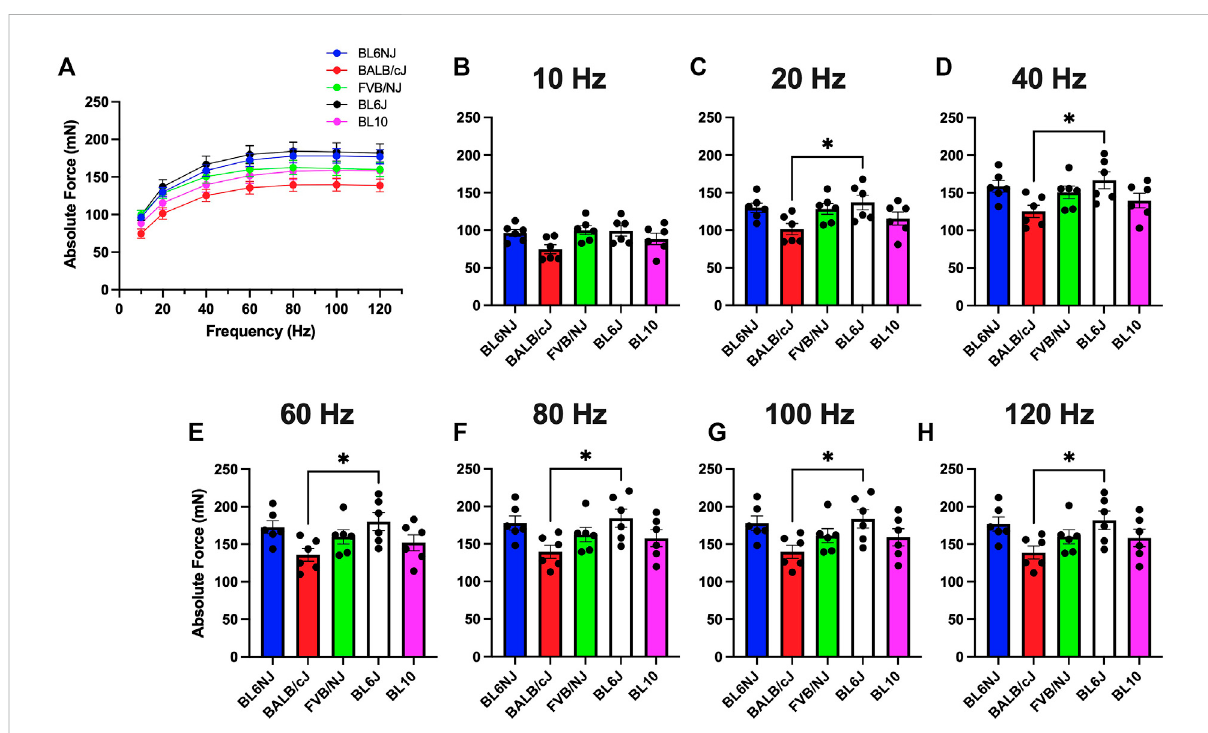
FIGURE 2 (A – H) .Absoluteisometricforceproductionofthesoleusmusclefromvariousstrainsofmice. (A) Force-frequencycurves(Blue=BL6NJ,Red= BALB/cJ, Green = FVB/NJ, Black = BL6J, Pink = BL10), (B) force produced at 10 Hz, (C) force produced at 20 Hz, (D) force produced at 40 Hz, (E) forceproducedat60 Hz, (F) forceproducedat80 Hz, (G) forceproducedat100 Hz, (H) forceproducedat120 Hz.Statistically signi fi cantdifference is indicated by one symbol = p <